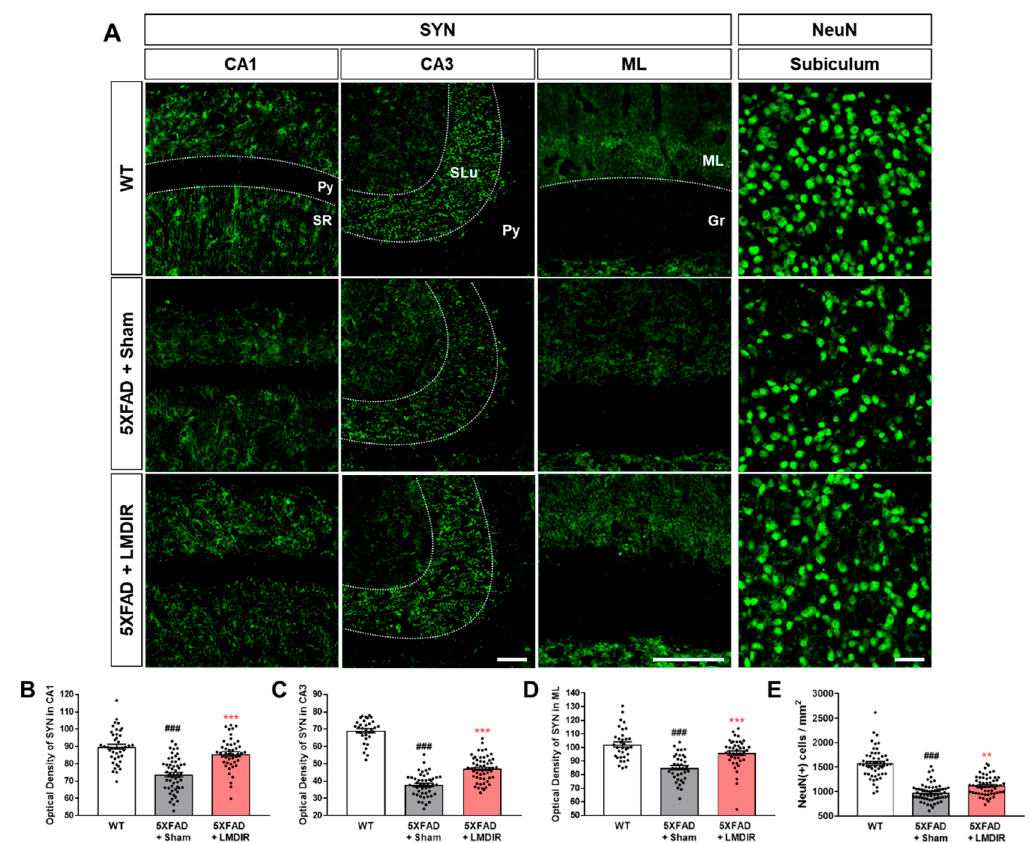
Figure 2. Protective effect of LMDIR against neurodegeneration in the hippocampal formation of 5XFAD mice. ( A ) Representative images of immunofluorescent staining of the hippocampal formation for NeuN, a marker of neurons, and SYN, a marker of pre-synaptic terminals. The fluorescence intensity of SYN immunoreactivity in the ( B ) CA1, ( C ) CA3 and ( D ) ML was significantly lower in the sham-exposed 5XFAD than in the WT mice. However, the decrease of SYN immunoreactivity in the brain of 5XFAD mice was significantly improved by LMDIR exposure. ( E ) The number of NeuN (+) cells per area was significantly lower in the sham-exposed 5XFAD mice than in the WT mice. However, the reduction of NeuN (+) cells in the brains of 5XFAD mice was significantly improved by LMDIR exposure. Data are presented as mean ± SEM ( n = 7 in each group). ### p < 0.001: WT mice versus sham-exposed 5XFAD mice. ** p < 0.01 and *** p < 0.001: sham-exposed 5XFAD mice versus LMDIR-exposed 5XFAD mice. Scale bar = 40 μ m for CA1, CA3 and subiculum. Scale bar = 100 μ m for ML. Py, pyramidal tract; SR, stratum radiatum; SLu, stratum lucidum; ML, molecular layer; Gr, granular layer; LMDIR, Low–moderate dose ionizing radiation; NeuN, neuronal nuclear antigen; SYN, synaptophysin.